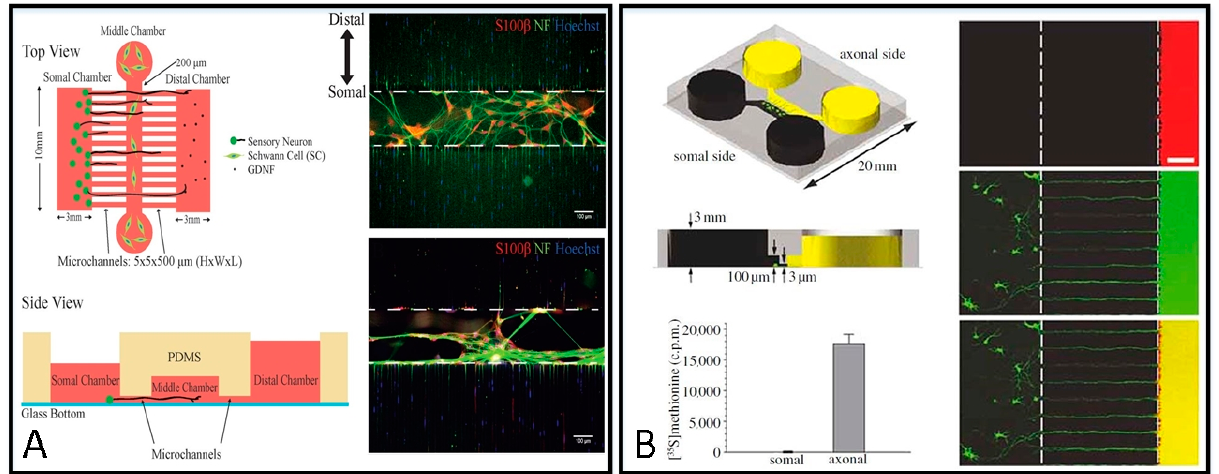
Figure 5. Microfluidic platforms for neurite outgrowth. ( A ) The microfluidic culture platform to simulate axon entrapment by Gokce, S. K. The left half of the figure shows the schematics of the microfluidic device. The right half part shows the normal SCs and GDNF-overexpressing SCs with axonal trapping in the middle chamber. ( B ) The microfluidic device to study the regeneration of injured CNS axon by Taylor, A. M.